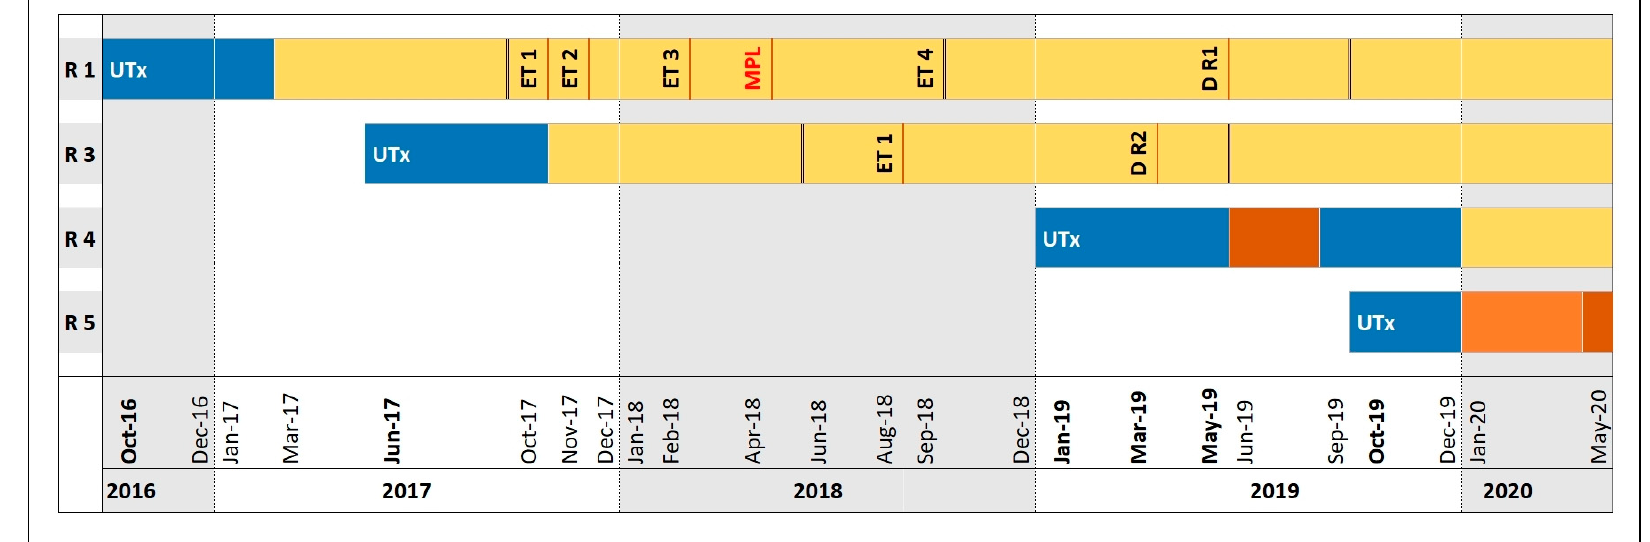
Figure 2. Major postoperative fertility and pregnancy related events and immunosuppressive treatment regimens in four uterus recipients. Regimen A, blue: induction with anti-thymocyte globulin (ATG) at 1.5 mg/kg body weight (bw) for 3 days; parallel start of a triple-drug immunosuppression (IS) regimen with tacrolimus (target trough level 10–12 ng/mL, starting dose 0.1 mg/kg bw), mycophenolate mofetil (MMF) 2× 1000 mg, and prednisolone, with prednisolone tapered from 100 mg/kg bw to 5 mg/kg bw over 3 weeks, then maintained at 5 mg/kg bw; tacrolimus target trough level after 3 months 8–11 ng/mL. Regimen B, yellow: triple-drug IS regimen replacing MMF with azathioprine (AZA), 1 mg/kg bw; tacrolimus target trough level checked every 2–4 weeks, also during pregnancy, and prednisolone retained at 5 mg maintenance dose. Dark orange: triple-drug IS with ciclosporin (80-0-80 mg, target level 100–130 ng/mL, AZA 75 mg 1-0-0, and prednisolone 5 mg 1-0-0). Orange: triple-drug IS with ciclosporin (100-0-100 mg, target trough level 100–130 ng/mL, MMF 2×1000 mg, and prednisolone 5 mg 1-0-0). Abbreviations: R, recipient; UTx, uterus transplantation; ET, embryo transfer; MPL, missed pregnancy loss at gestation week 9; D R1, delivery by Recipient 1 on 07 May 2019; D R2, delivery by Recipient 2 on 31 March 2019. Vertical black lines delimit 12-month periods of immunosuppression.